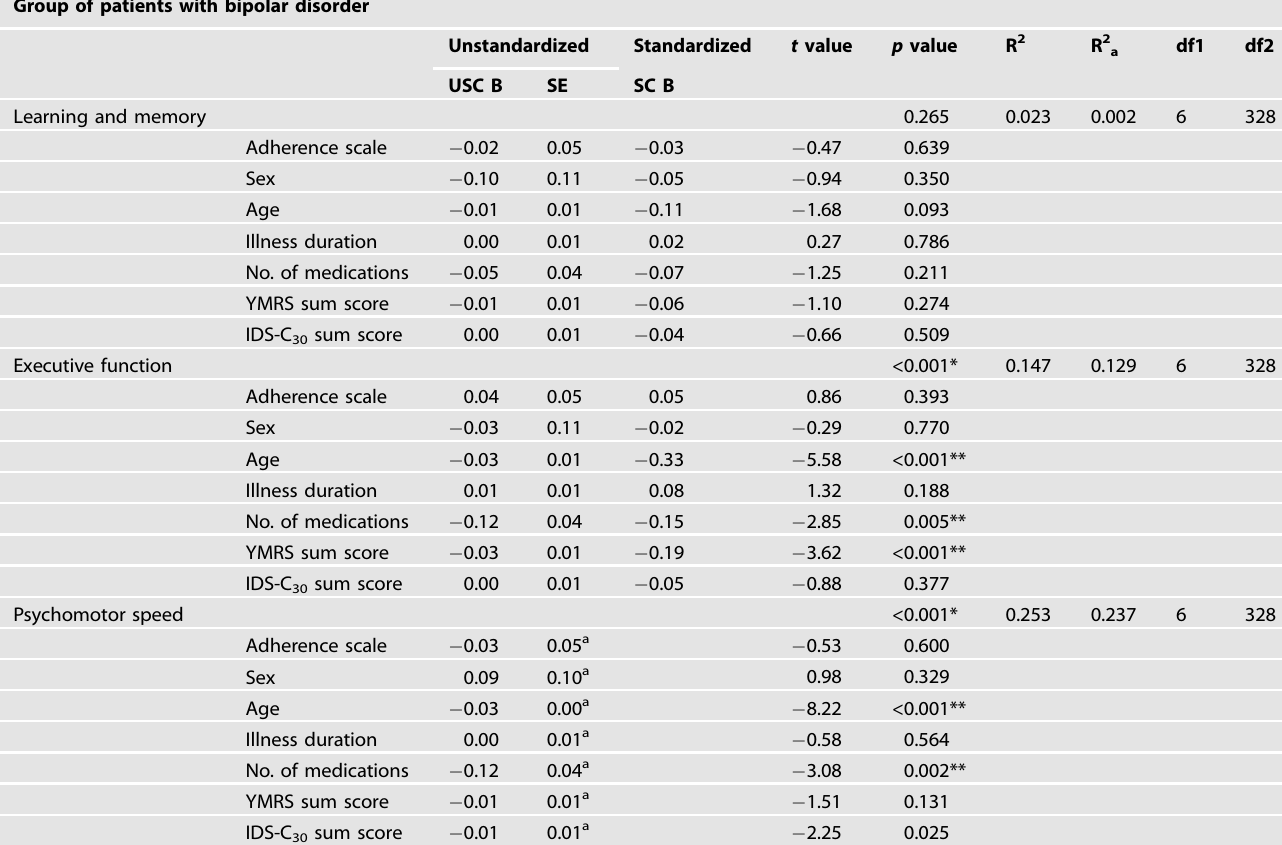
Table 4. Multiple linear regression analyses in the group of patients with bipolar disorder with cognitive performance as the dependent variable and adherence behavior, sex, age, duration of illness, number of medications, Young Mania Rating Scale, and Clinician Inventory of Depressive Symptomatology (IDS-C 30 ) as the